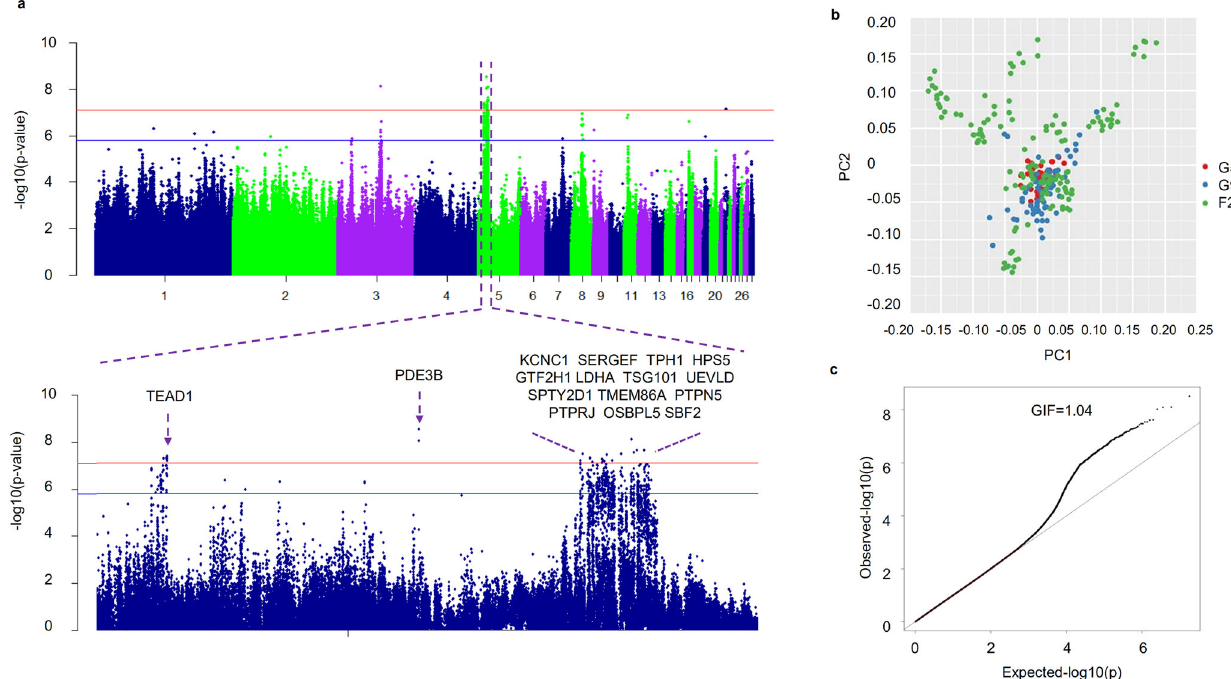
Fig. 3 Selective sweep associated with lower H/L ratio. a A GWAS on H/L in chicken peripheral blood identi fi ed a 1-Mb region on chromosome 5. Red horizontal dashed lines indicate the Bonferroni-corrected signi fi cance threshold (7.1 × 10 − 8 ). b Population structure evaluated on the basis of the fi rst two principal components. c Quantile – quantile (Q – Q) plot of the GWAS results. The x-axis shows the expected p values under the null hypothesis, and the y-axis the observed p -values. The GIF (genomic in fl ation factor) was 1.04 for H/L, which suggests that the population structure was well